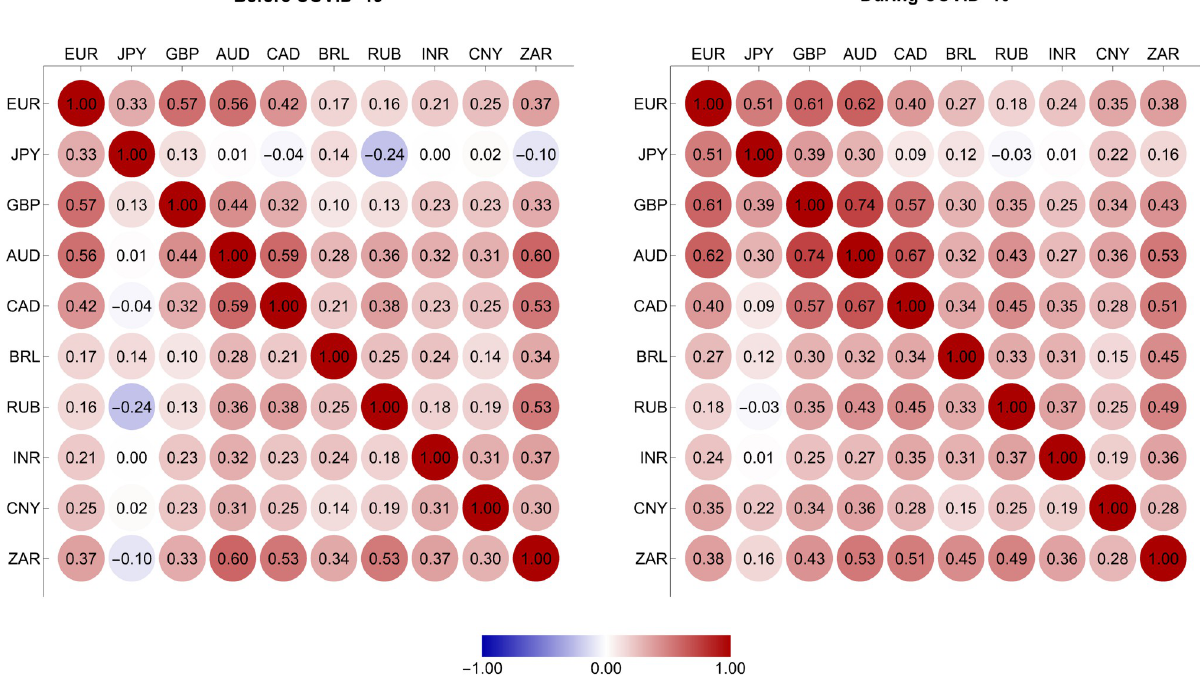
Fig 3. Empirical correlation matrices of the returns of currency exchange